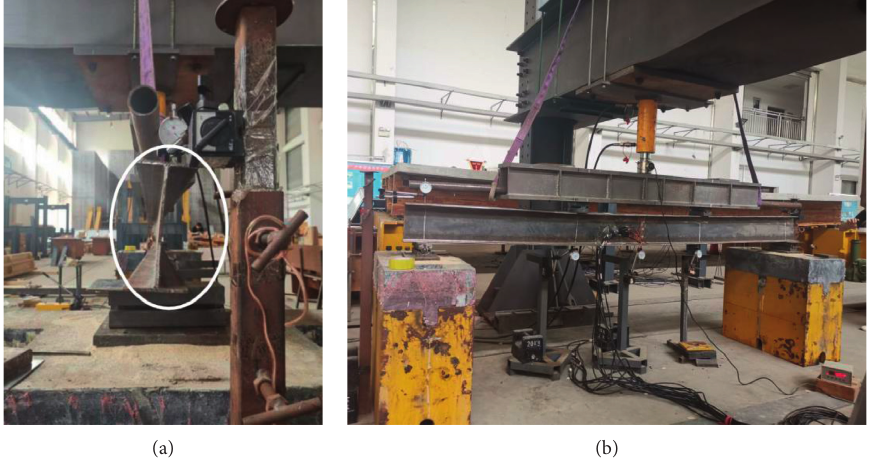
Figure 6: Failure mode of L1 test piece. (a) Lateral bending. (b) Instability failure.